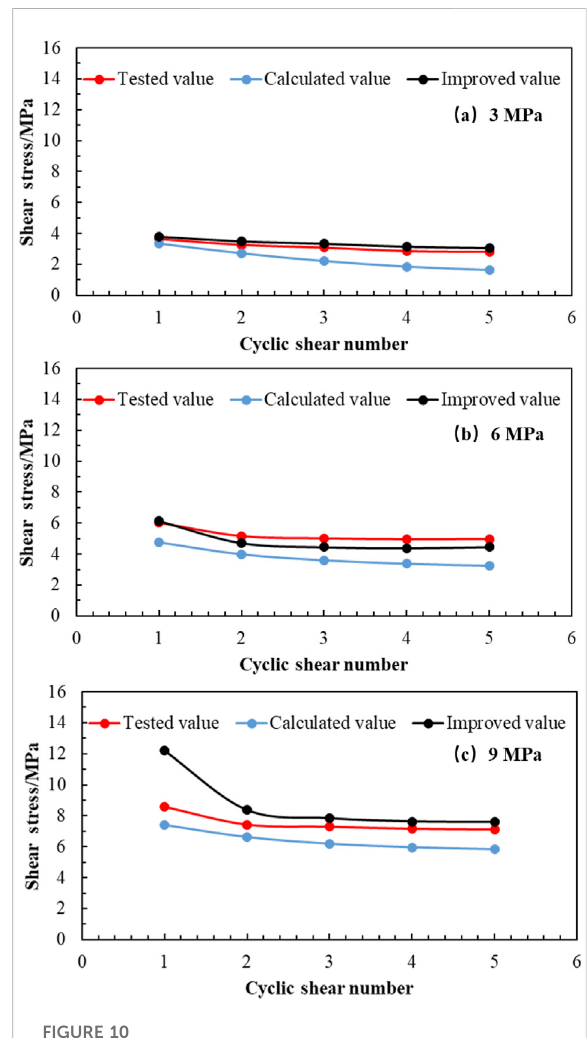
FIGURE 10 Shear stresses obtained by tests, proposed method, and improved method under different normal stress of 3, 6 and 9